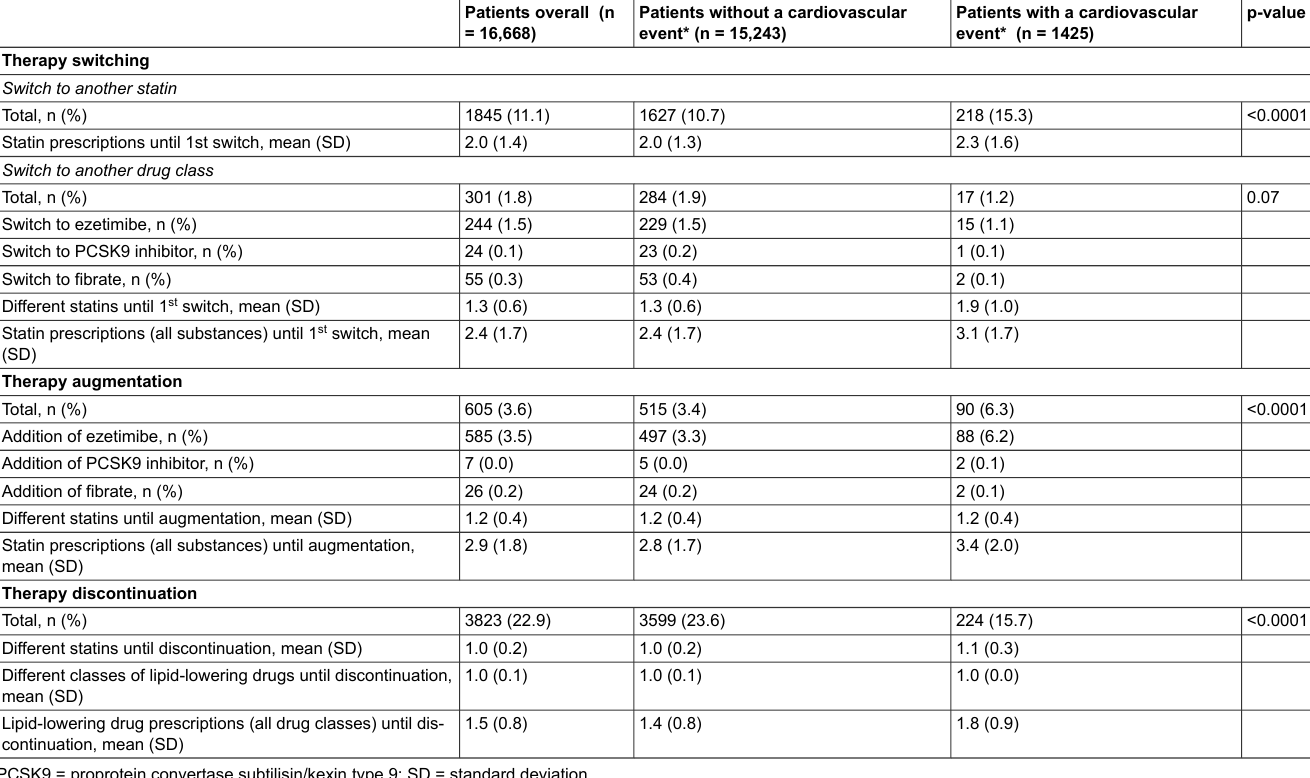
Table 4: Switching, augmentation and discontinuation of the lipid-lowering therapy among patients in the Helsana population with a first-time statin prescription in the year 2017 during a follow-up period of 18 months.